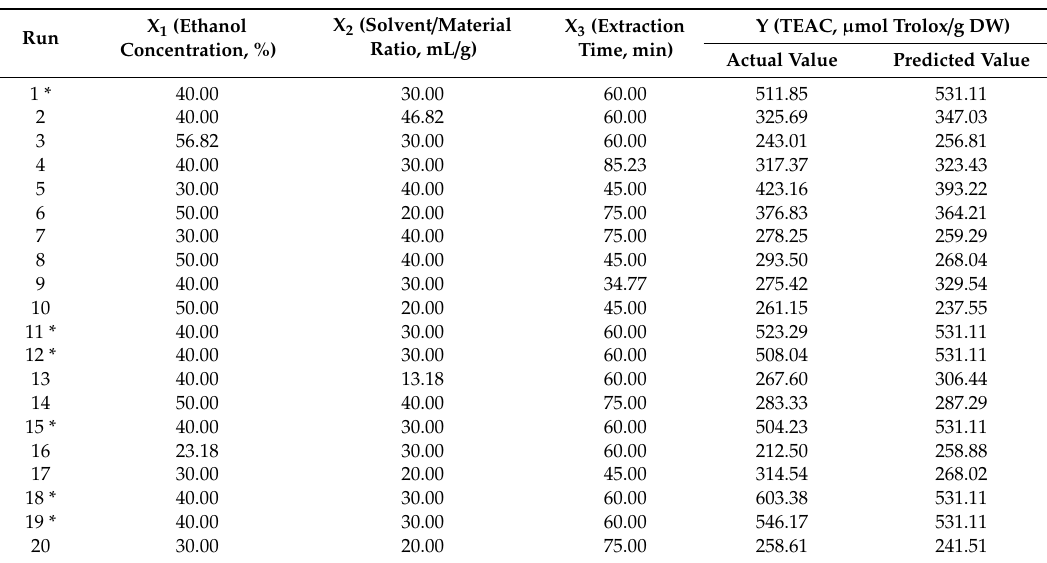
Table 2. The experimental design, experimental value, and predicted value of